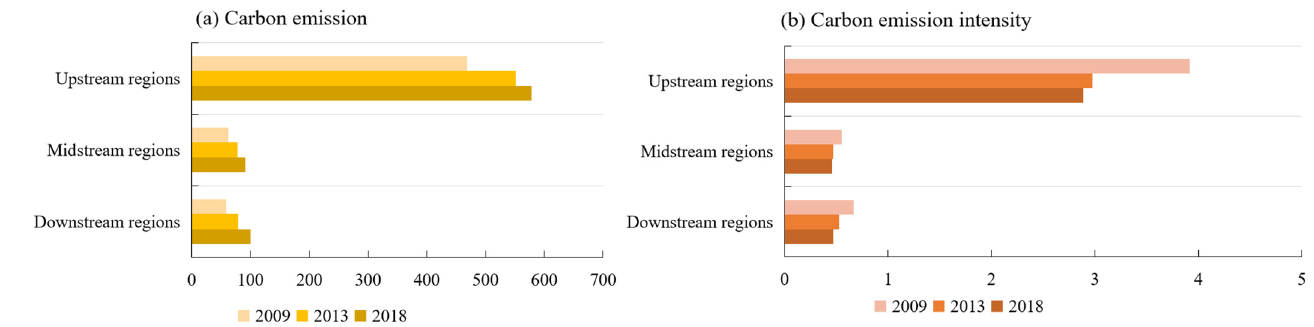
Figure 4. Agricultural carbon emission and carbon emission intensity in different